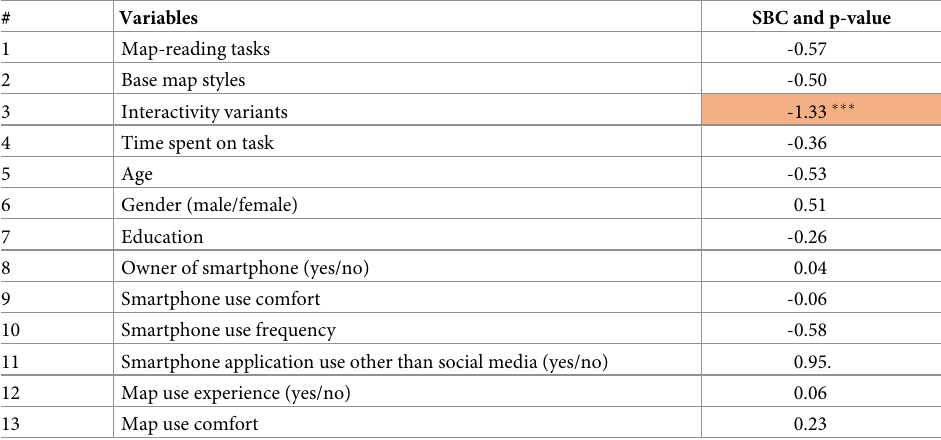
Table 3. Regression model with task success as the dependent variable (see S3 Table for odds